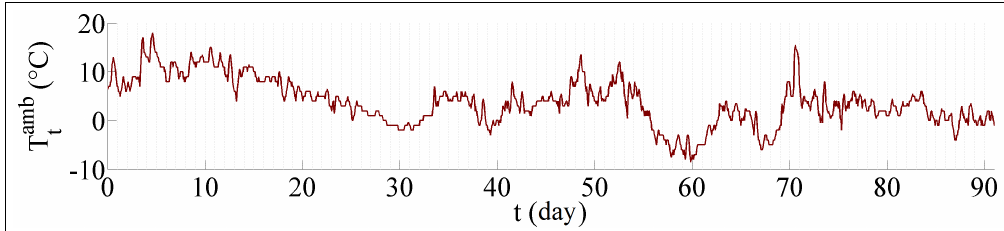
Figure 3. The ambient temperatures for the simulation